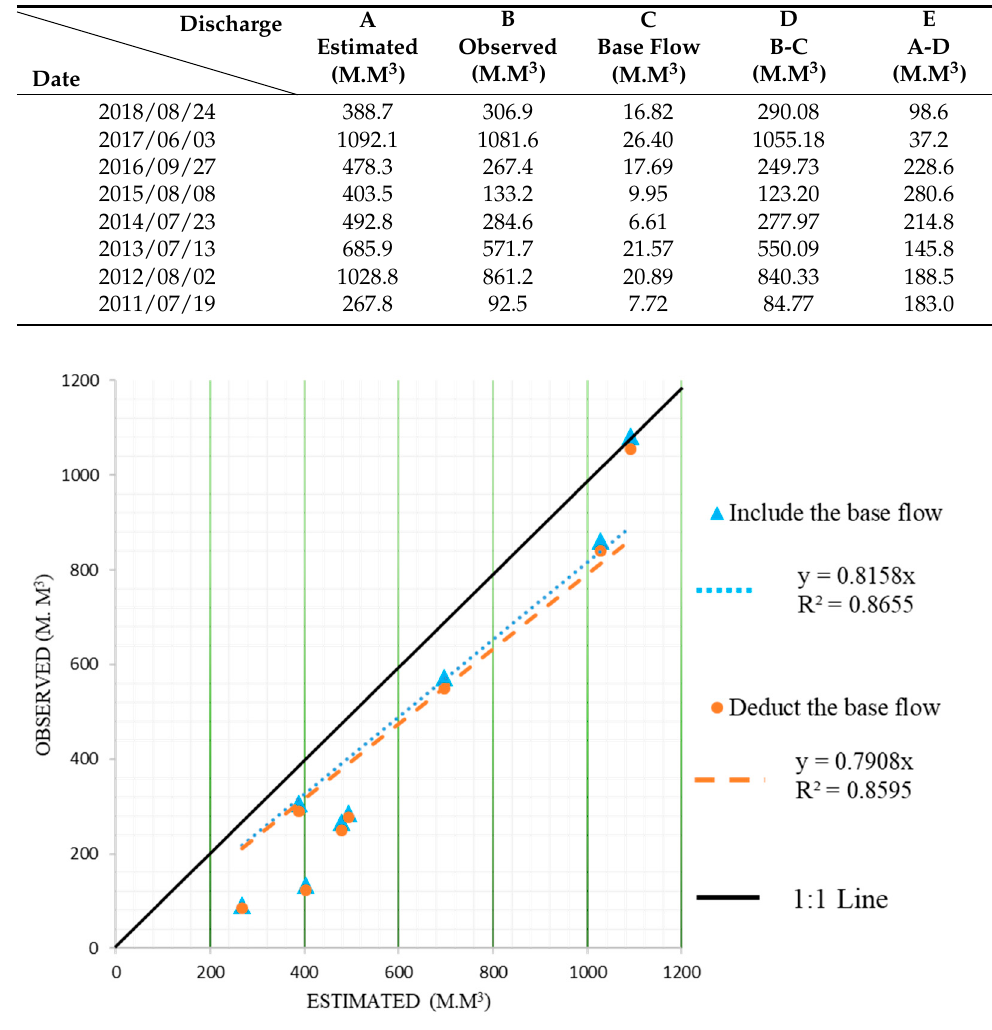
Table 4. Observation and estimation of the maximum discharge events in each year.